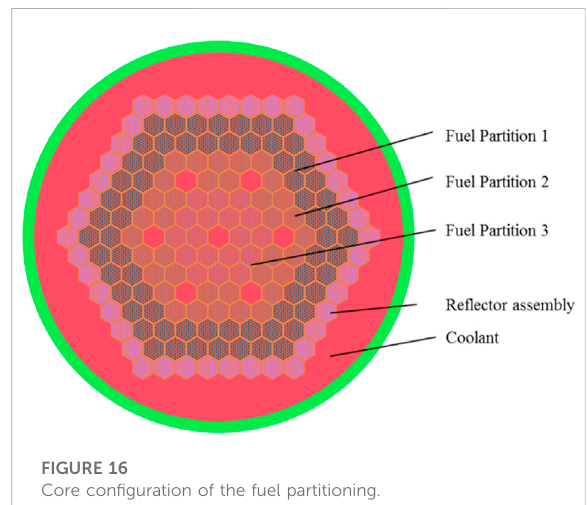
FIGURE 14 Energy spectrum results on the beginning of life of the fuel material analysis.